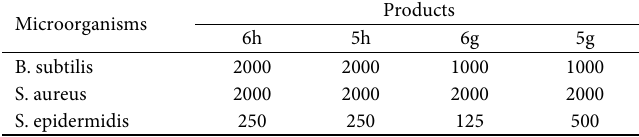
Table 3. Minimum inhibitory concentration (MIC in µg/ml) values of the effective synthesized